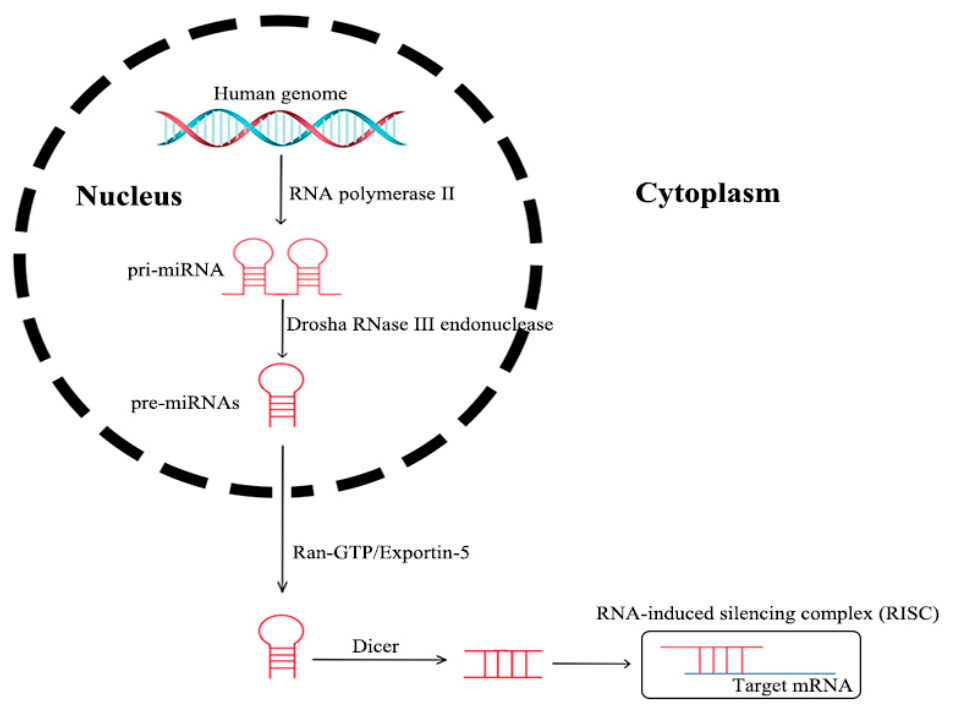
Figure 3. Processing of miRNAs.